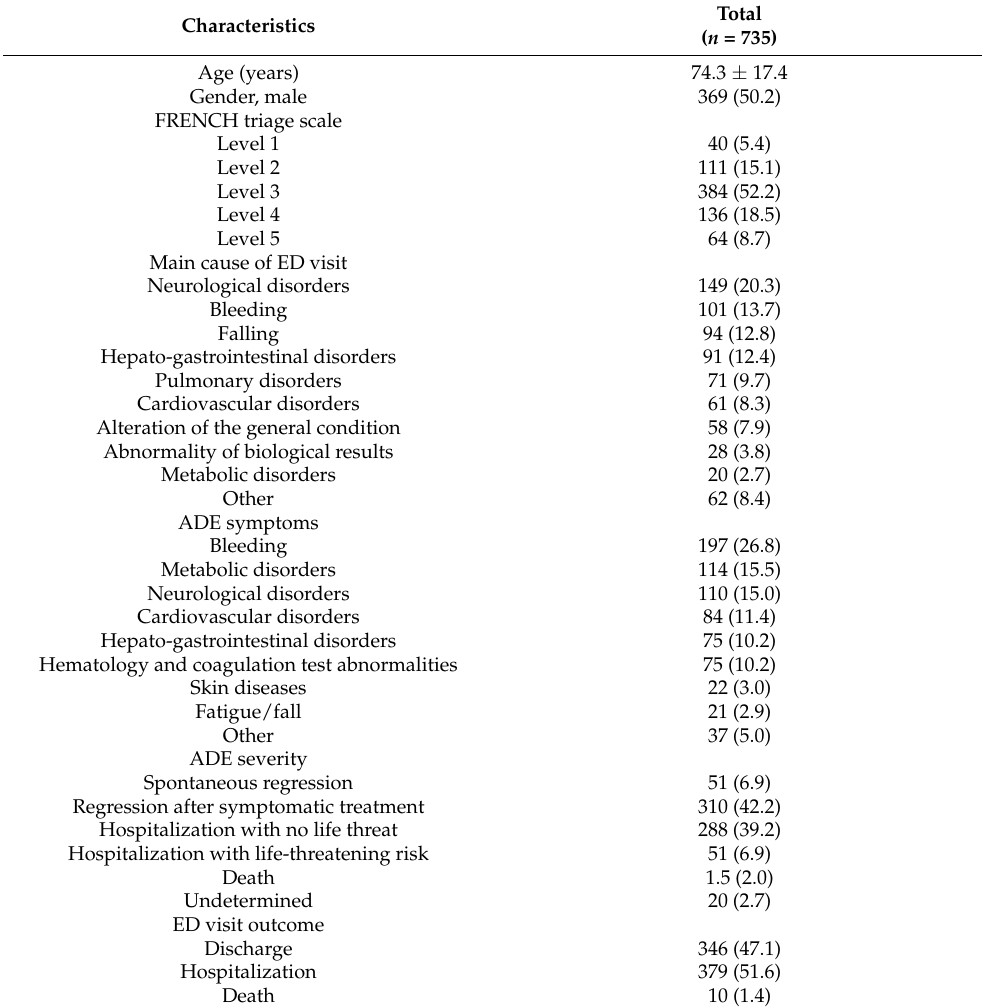
Table 1. Characteristics of the study